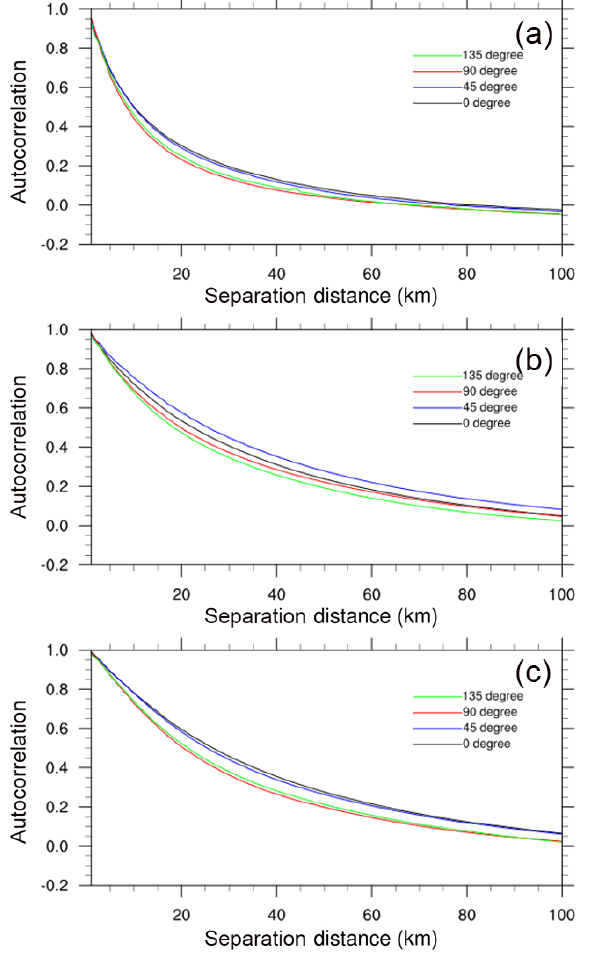
Figure 4. The averaged directional spatial autocorrelation of pre- cipitation for (a) HPFP, (b) LPMP, and (c) HPMP.